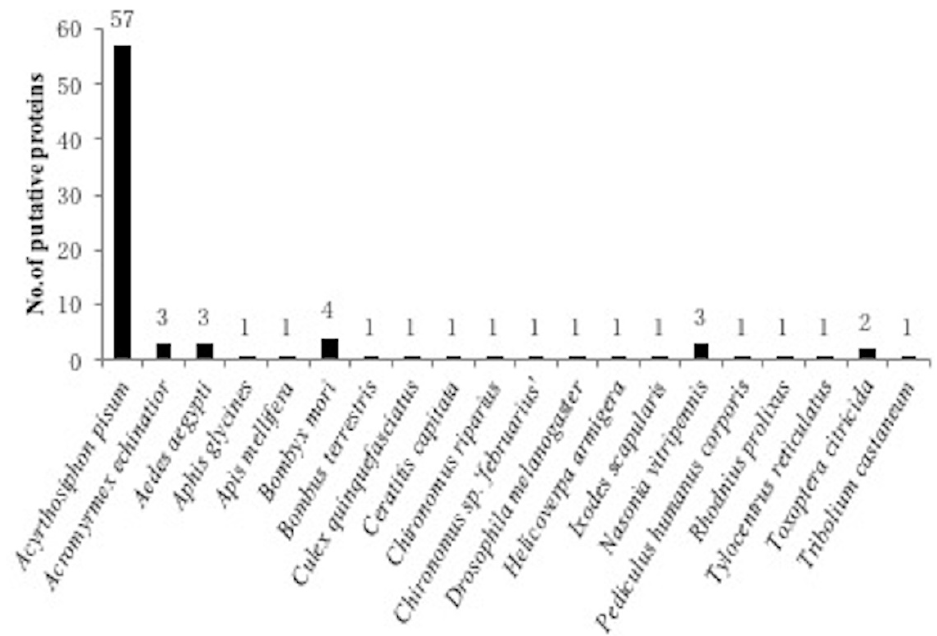
Figure 5. Distribution of the 86 putative proteins sequences similar to those of Sitobion miscanthi identified from other insect species in a BLASTX search.